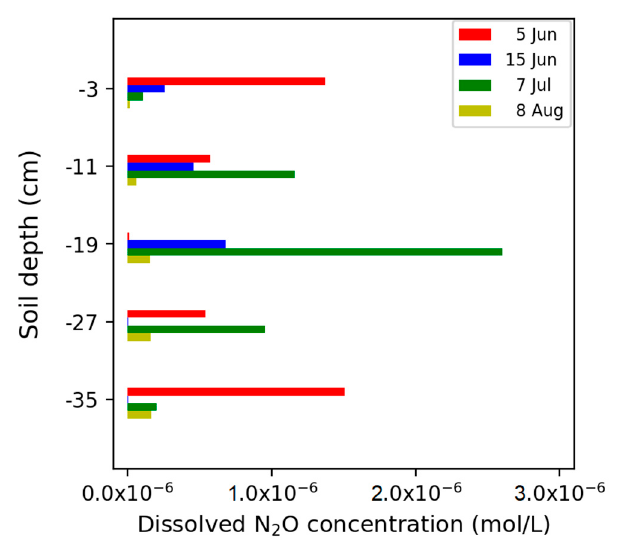
Figure 8. Concentration of dissolved N 2 O.